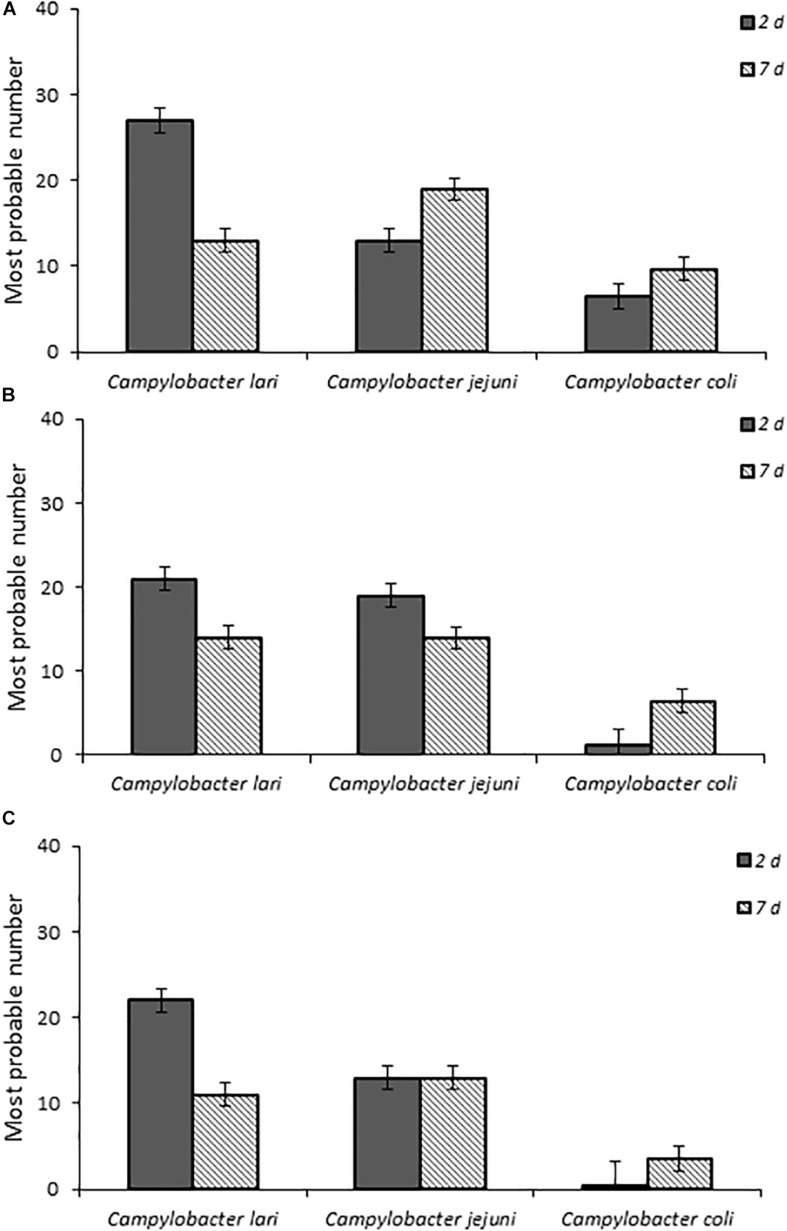
Fecal bacterial burden in infected chicks with Campylobacter spp. laboratory isolates at doses (A–C), respectively, as determined by the most probable number (MPN) calculations as described in section “Materials and Methods” and in Supplementary Table S1.